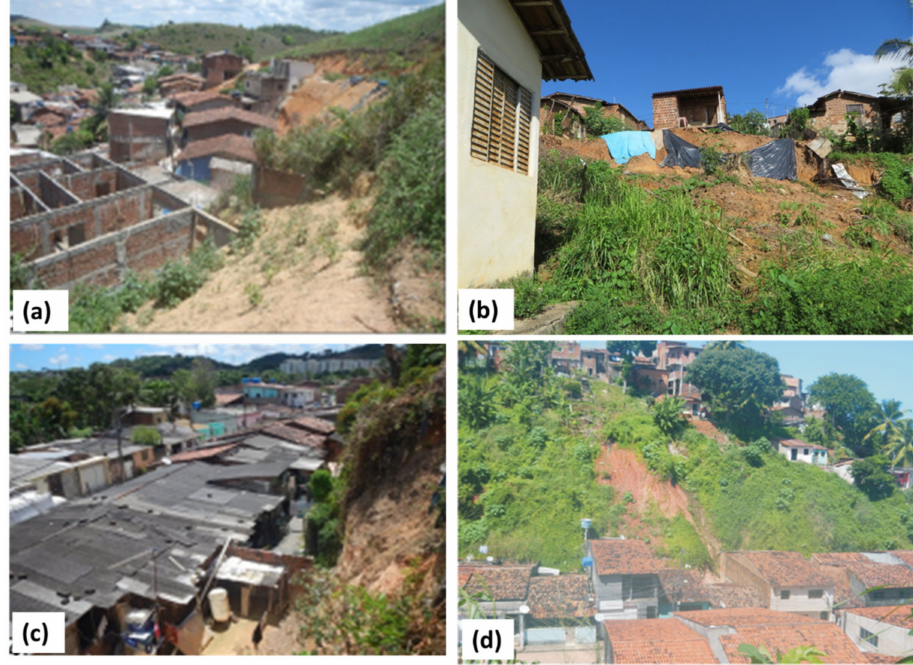
Figure 6. Residences built in high-risk areas subject to landslide events in the cities of Ipojuca ( a ), Jo ã o Pessoa ( b ), Jaboat ã o dos Guararapes ( c ) and Macei ó ( d ). Source: CPRM (2020).